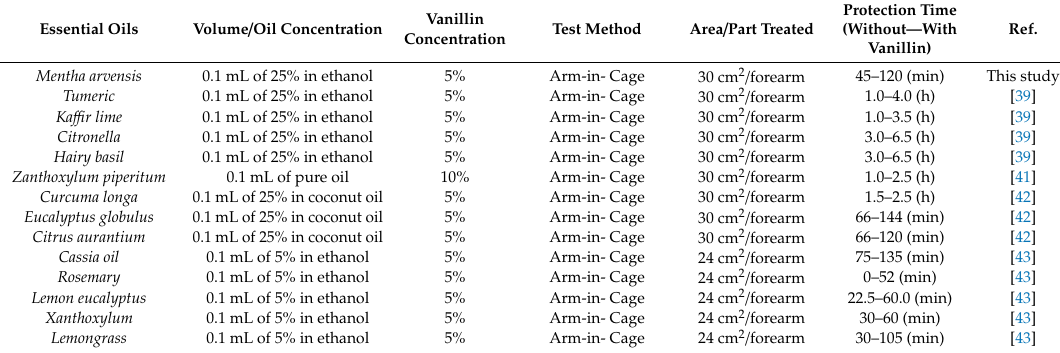
Table 3. A review of protection times of essential oils with or without vanillin, against Aedes aegypti